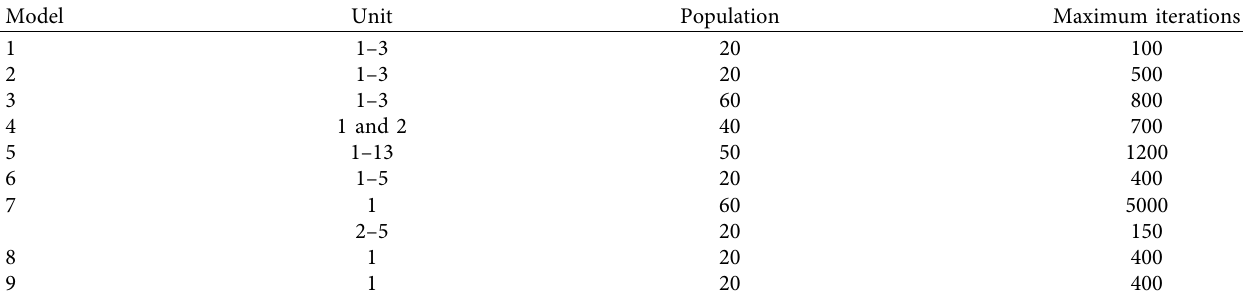
Table 5: Parameters of GBO and IGBO.